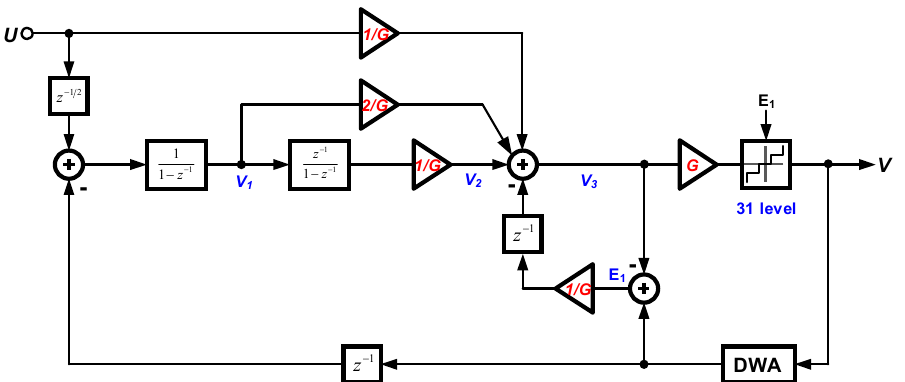
Figure 4. Block diagram of the proposed ΔΣ modulator with relaxed feedback timing and gain scaling.